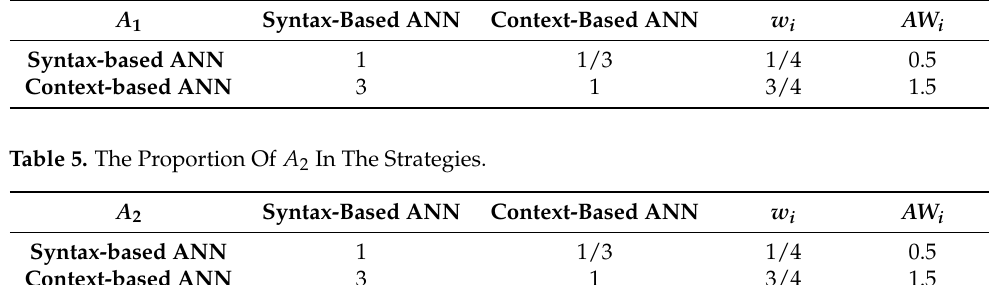
Table 4. The Proportion Of A 1 In The Strategies.